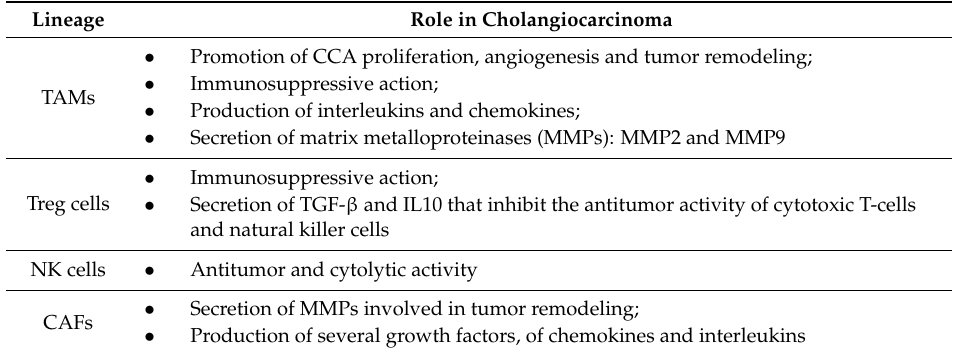
Table 1. Cellular components of tumor